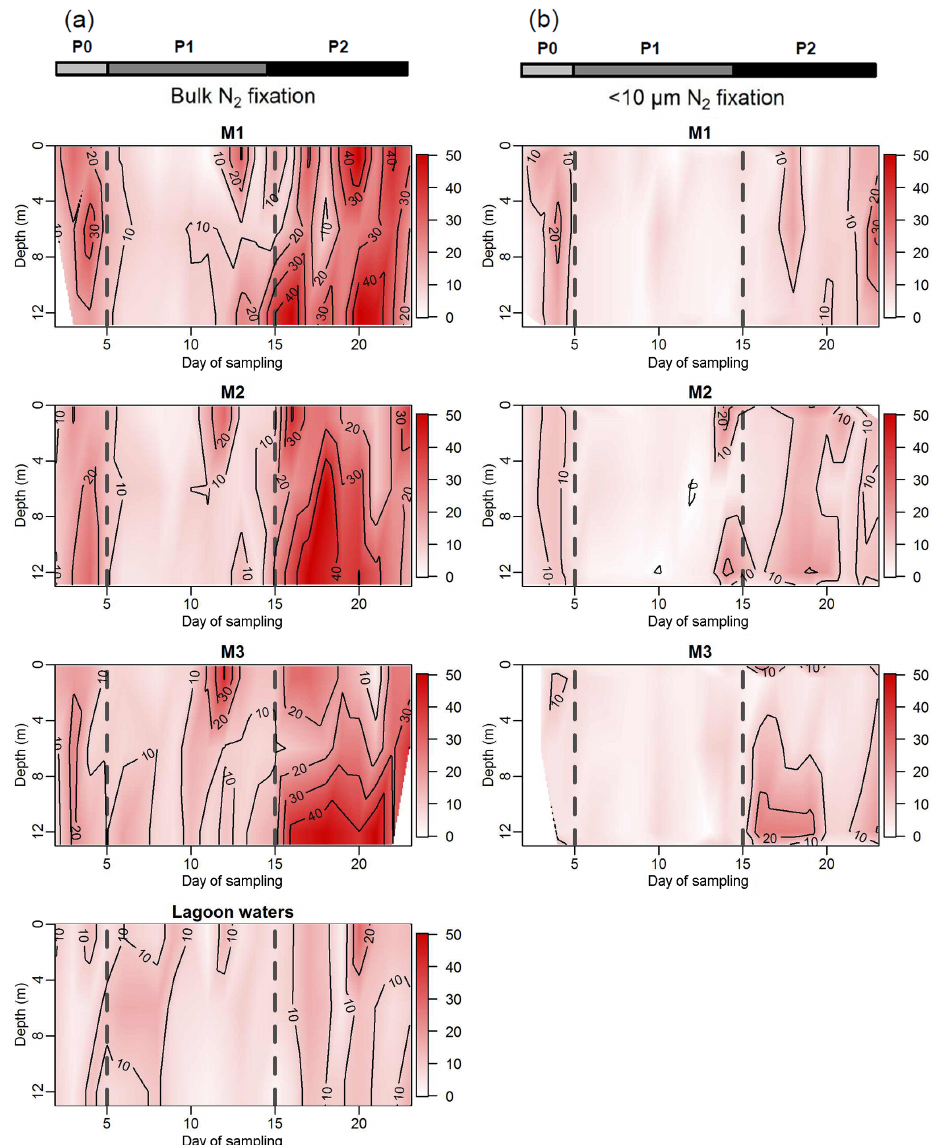
Figure 2. (a) Horizontal and vertical distributions of bulk N 2 fixation rates (nmolNL − 1 d − 1 ) in M1, M2, M3 and lagoon waters, and (b) <10µmN 2 fixation rates (nmolNL − 1 d − 1 ) in M1, M2, and M3. Note that N 2 fixation rates in the <10µm fraction were not measured in lagoon